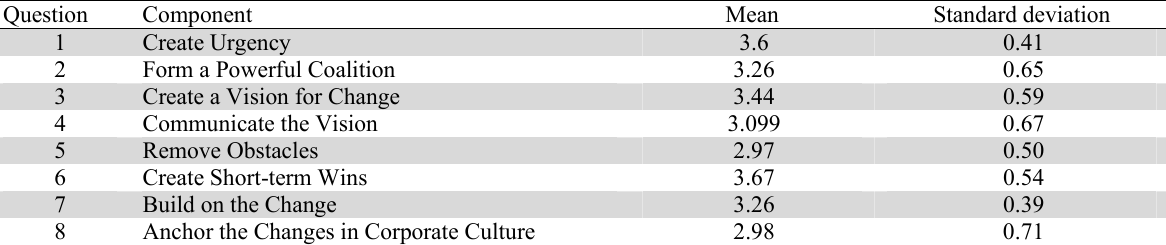
The results of mean and standard deviation of eight